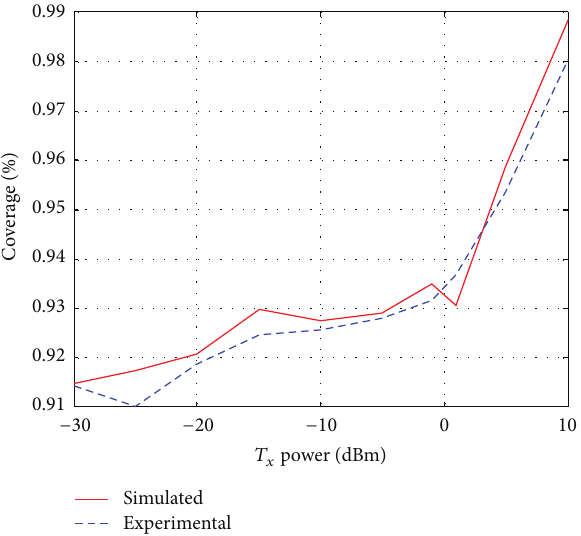
Figure 14: Received power in different scenarios.